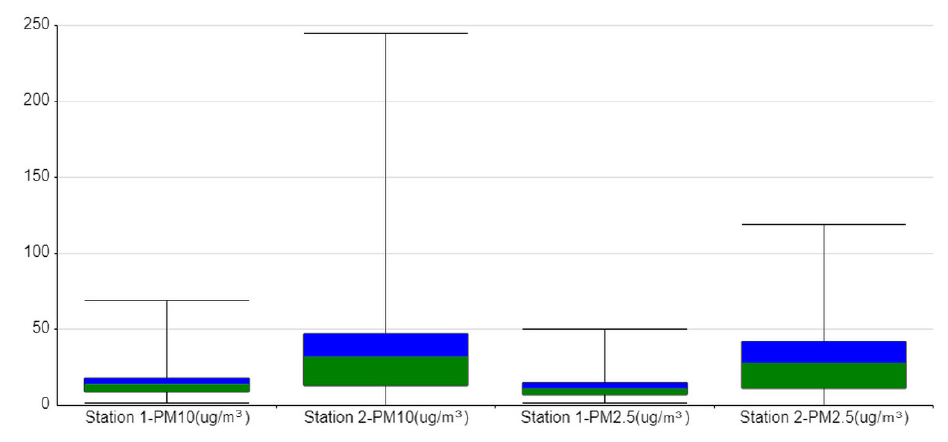
Figure 7. Box plot diagram.